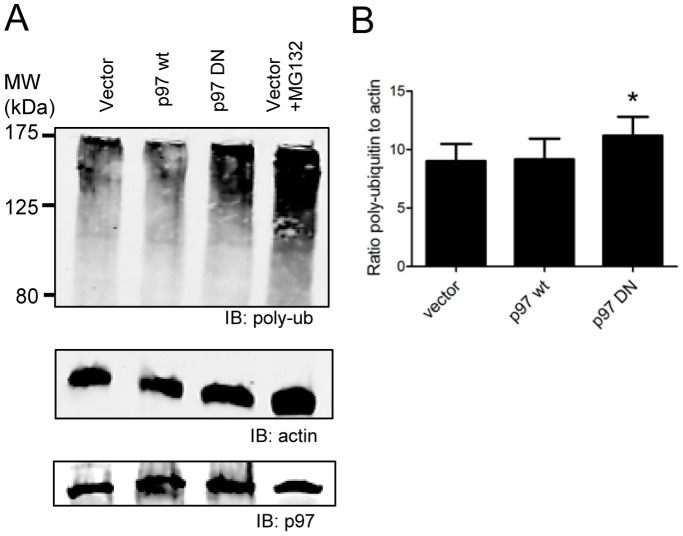
Poly-ubiquitinated proteins accumulate in cells expressing DN p97.Total cell lysates were prepared 24 hours after transfection with empty vector, wild type p97, or DN p97 protein and analyzed by SDS-PAGE and western plot analysis. A. Blots were stained with anti-poly-ubiquitin monoclonal antibodies (top), anti-actin polyclonal antibodies (middle), or anti-p97 monoclonal antibodies (bottom). B. Signals of both poly-ubiquitin conjugated protein were normalized to actin levels in the cell and are depicted graphically. The average ratio of poly-ubiquitin signal to actin for four experiments is plotted. DN p97 expression resulted in a statistically significant accumulation of poly-ubiquitin conjugates in cells (p<0.05).